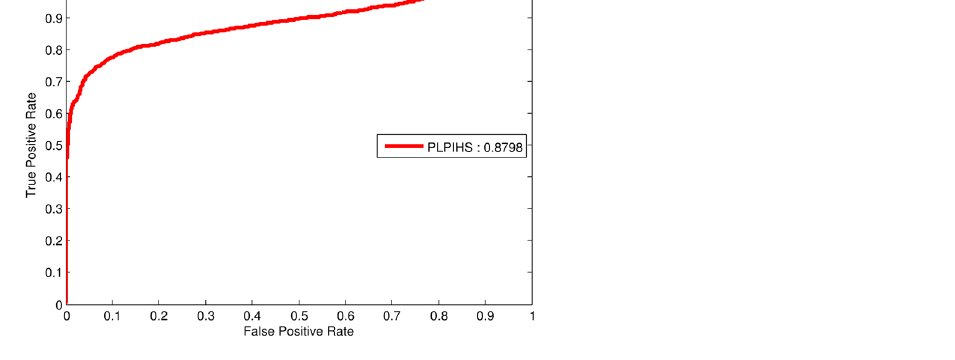
Figure 6. The ROC curves of the independent test set in